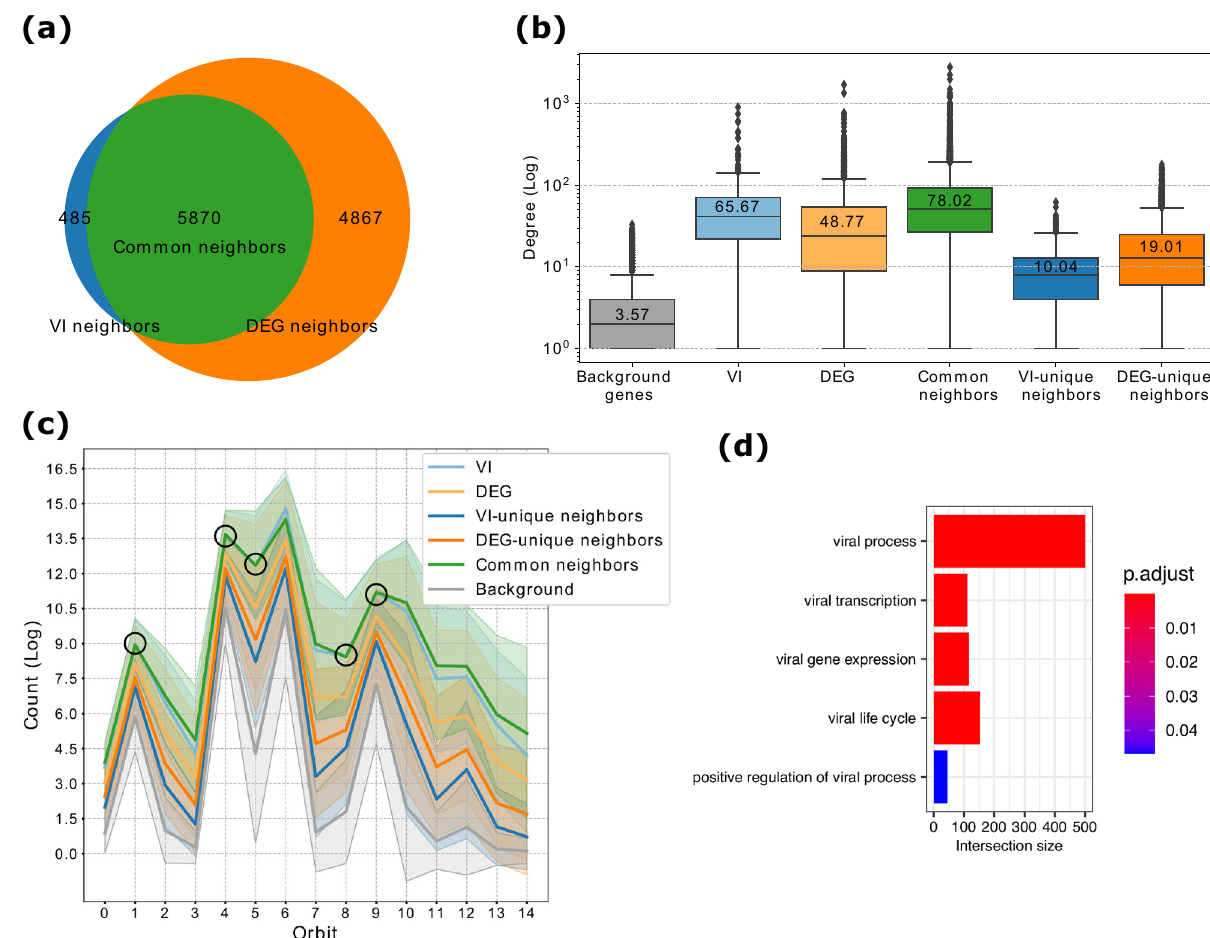
Figure 3. Common Neighbors are key genes in the molecular interaction network (MIN). (a) Venn Diagram showing the overlap between VI neighbor and DEG neighbor gene sets. (b) Comparison of the average degrees (given on the vertical axis) for the different gene sets (given on the horizontal axis) based on their degrees in the MIN. All pair-wise comparisons between these are statistically significant with p < 0.0001, using two-sided Mann–Whitney–Wilcoxon test. (c) GDV signatures for the VI, DEG, VI-unique neighbors, DEG-unique neighbors, common neighbors and background gene sets. All pair-wise comparisons between the counts (on the vertical axis) of the orbits (denoted by 0 to 14 on on the horizontal axis) of common neighbors and the rest of the gene sets are statistically significant with p < 0.05, using two-sided Mann-Whitney-Wilcoxon test, except for the orbits marked with a black circle between common neighbors and VI gene set. (d) Enrichment analysis of the common neighbor genes in the MIN. The bar plot is showing the enrichments related to viral processes. The complete list can be found in Supplementary Table S5. The intersection size (on horizontal axis) is the number of common neighbors genes that are annotated with the corresponding GO term (on the vertical axis). The adjusted p-value, “p.adjust”, is obtained by the Set Counts and Sizes correction method. This method considers the dependency of multiple tests by taking into account the overlap of functional terms (on